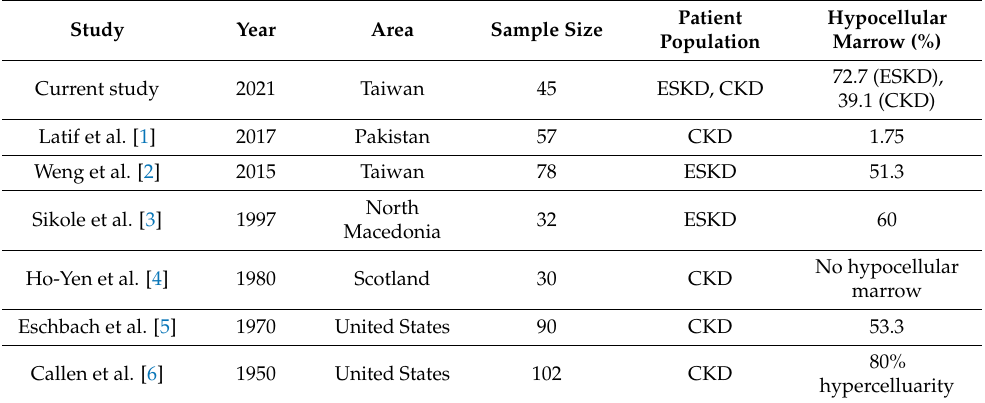
Table 1. Published literature on bone marrow pathology in patients with kidney